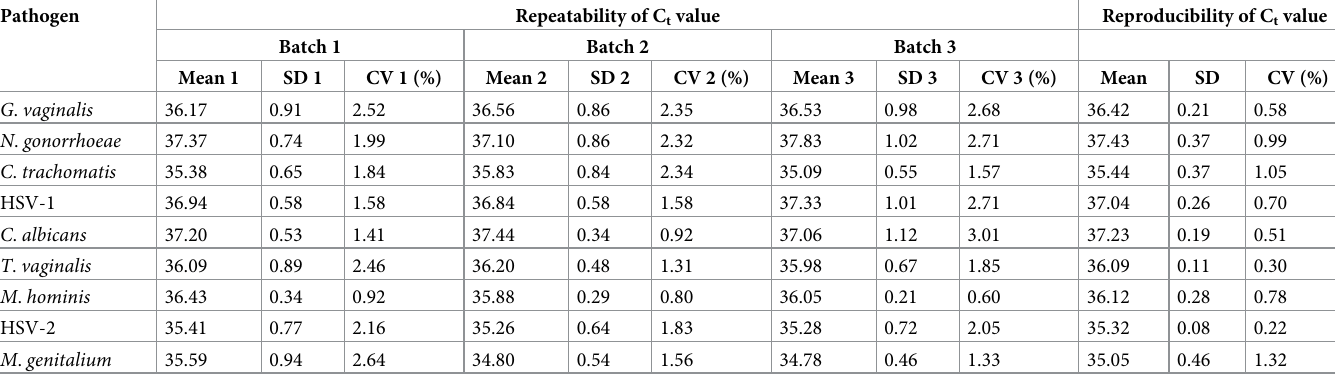
CV, coefficient of variation; SD, standard